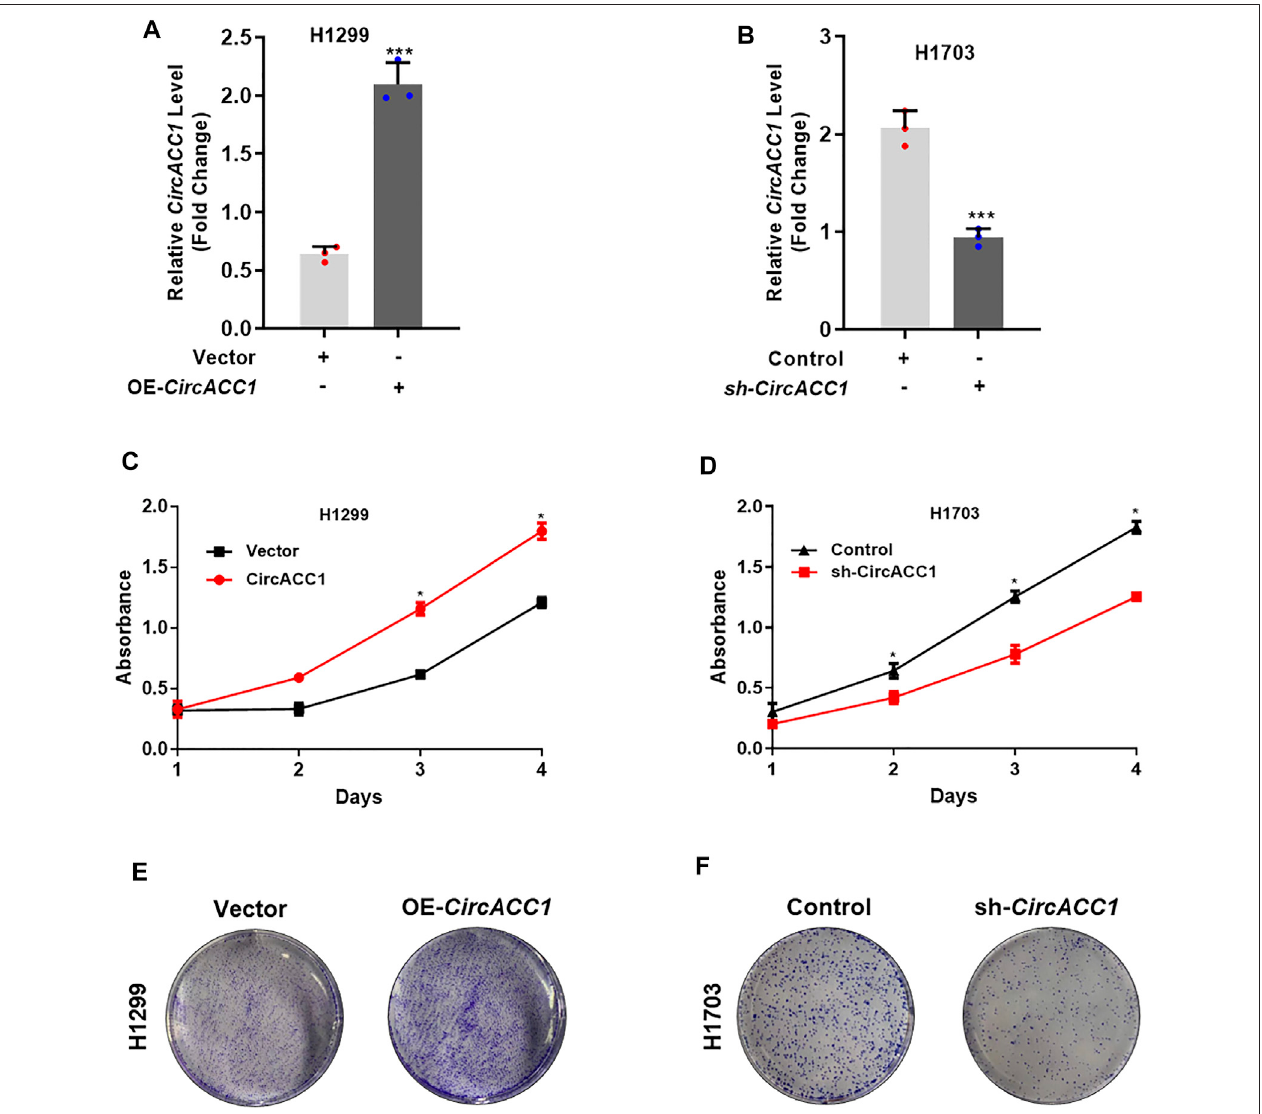
FIGURE 2 | CircACC1 is contributes to cell growth of NSCLC. (A) . The expression of circACC1 in H1299 cells transfected with circACC1 overexpression plasmid or control vector; (B) . The expression of circACC1 in H1703 cells transfected with the shRNAs or control. Data are mean ± SD. *** p < 0.001; (C,D) . The effect of circACC1 on cell viability by CCK-8 assay. Data are mean ± SD. * p < 0.05; (E) . Images of cell proliferation by colony formation assay.